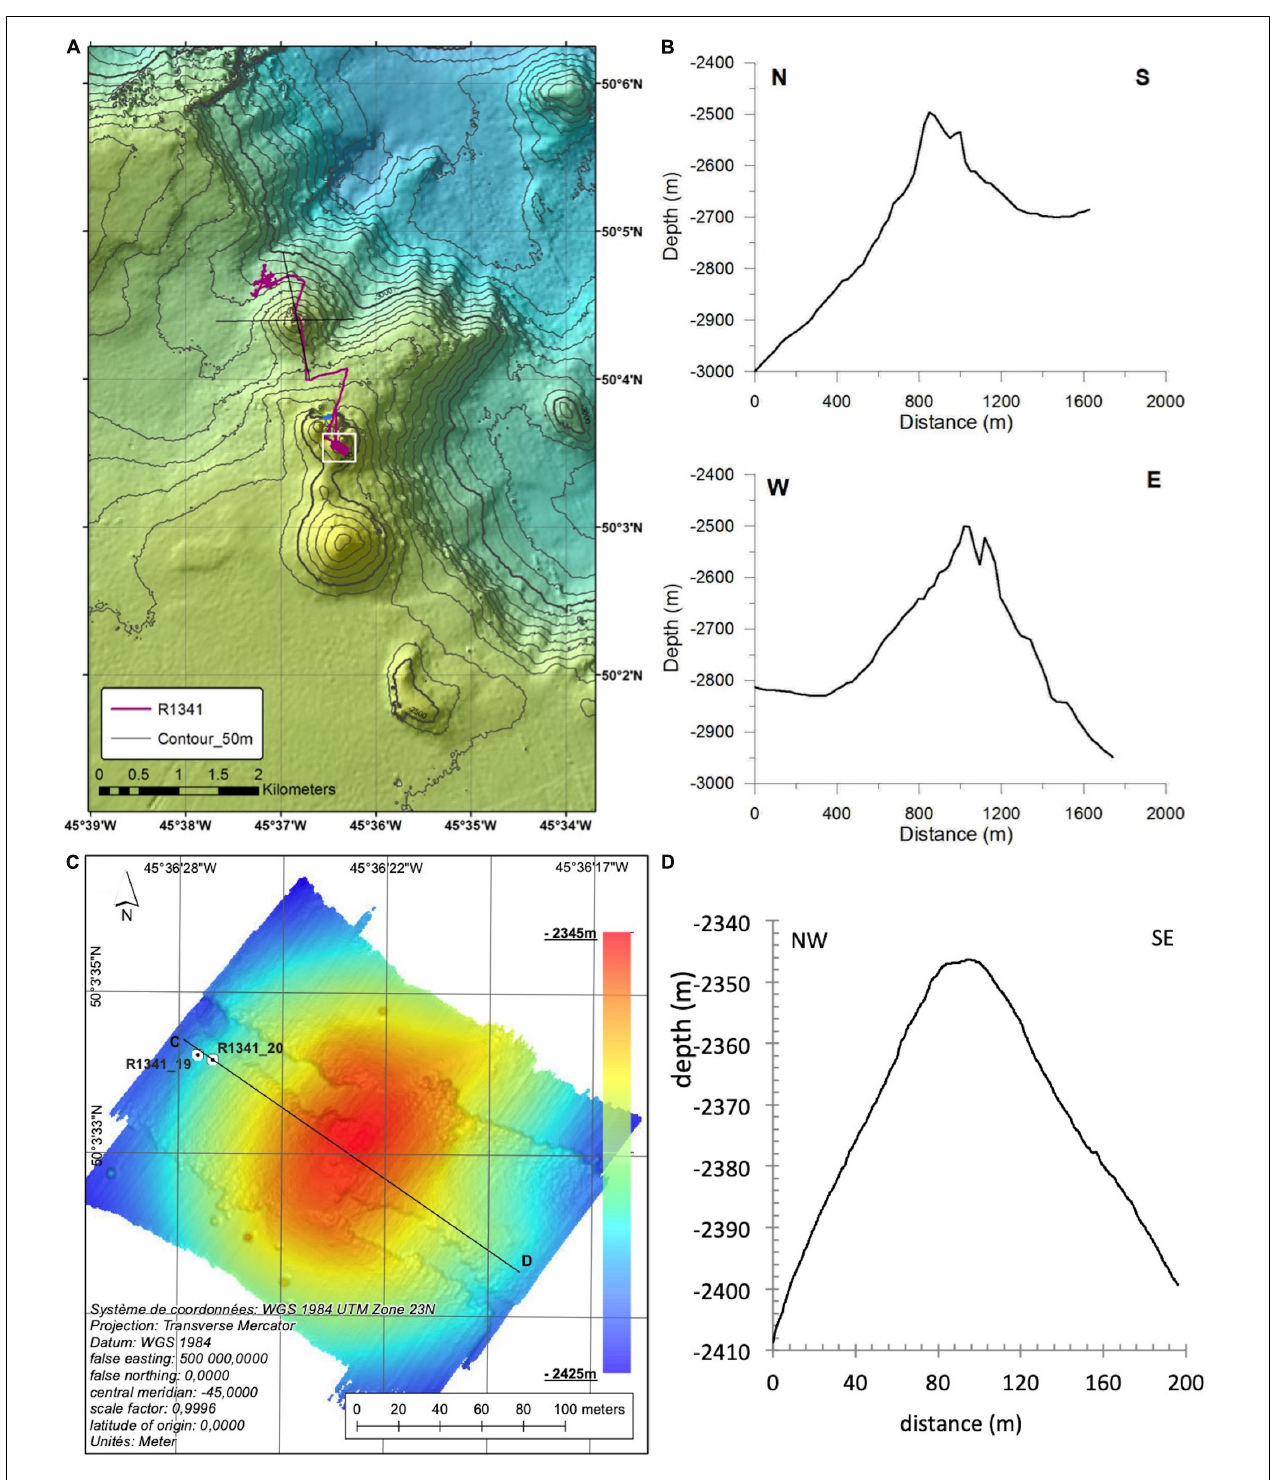
FIGURE 6 | Detailed bathymetry of mounds on the SE tongue of Orphan Knoll. (A) ICY_LAB multibeam sonar of mounds surveyed on ROPOS dive R1341. Multibeam sonar gridded to 26 m resolution. (B) Bathymetric profiles of the first mound encountered on dive R1341, based on 2017 ICY-LAB multibeam data. Full mound profiles are slightly concave, consistent with conical shape in 3D. (C) Near-bottom ROV-based bathymetry of SE Orphan Knoll mound mapped during ROV dive R1341, at 25 cm grid. The domal shape of the mound is evident despite the swath/navigation artifacts that we were unable to remove from the sonar data. These artifacts are likely related to the maximum 5 Hz navigation data available for ROV position. (D) Bathymetric profile C–D across mound, based on near-bottom ROV-based multibeam sonar parallel to multibeam acquisition swaths to minimize influence of position and swath artifacts.